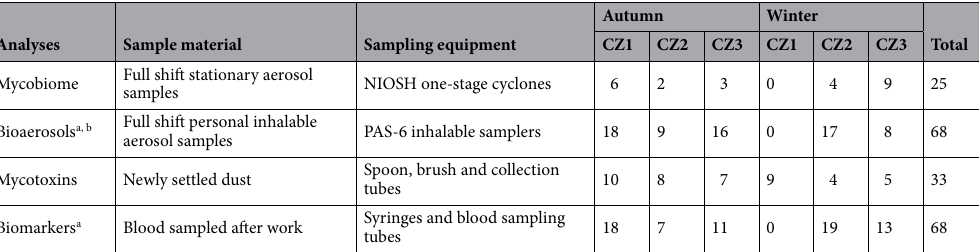
Table 4. Overview of the acquisition and number of samples for each sample set. a For bioaerosols and biomarkers, the number of samples equals the number of exposed workers. b The number of bioaerosol samples represent parallel sampling for analyses of dust, fungal spores and β1 → 3-glucans. CZ climatic zone. The number of companies grouped in CZ1, CZ 2 and CZ3 was 6, 7 and 7, respectively. All samples were collected at the same day during winter and autumn